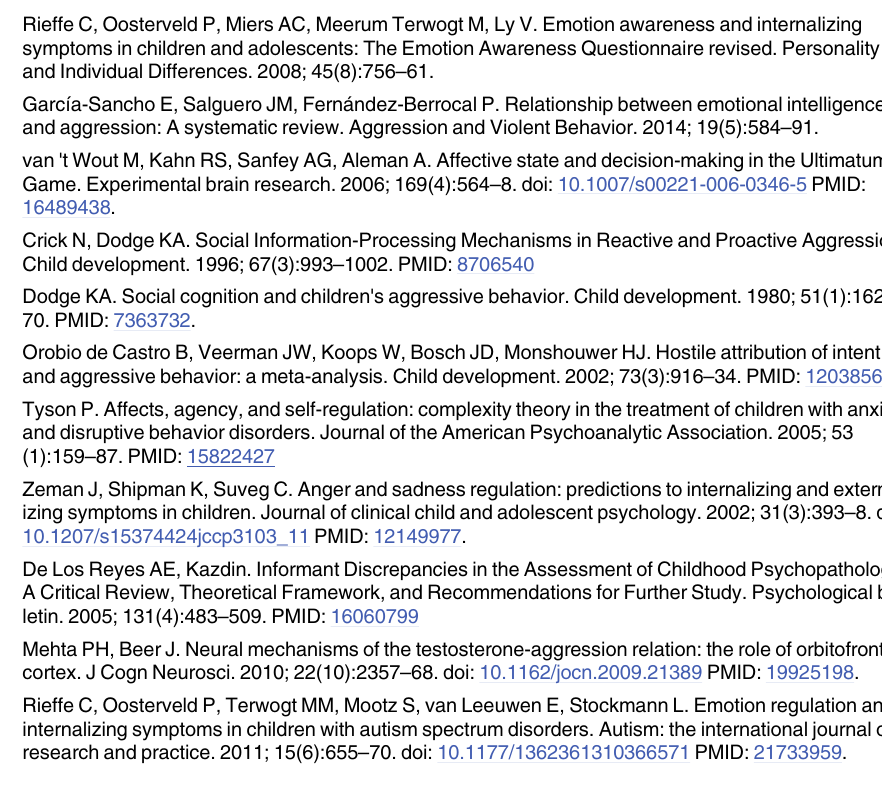
PLOS ONE | DOI:10.1371/journal.pone.0159323 July 15,